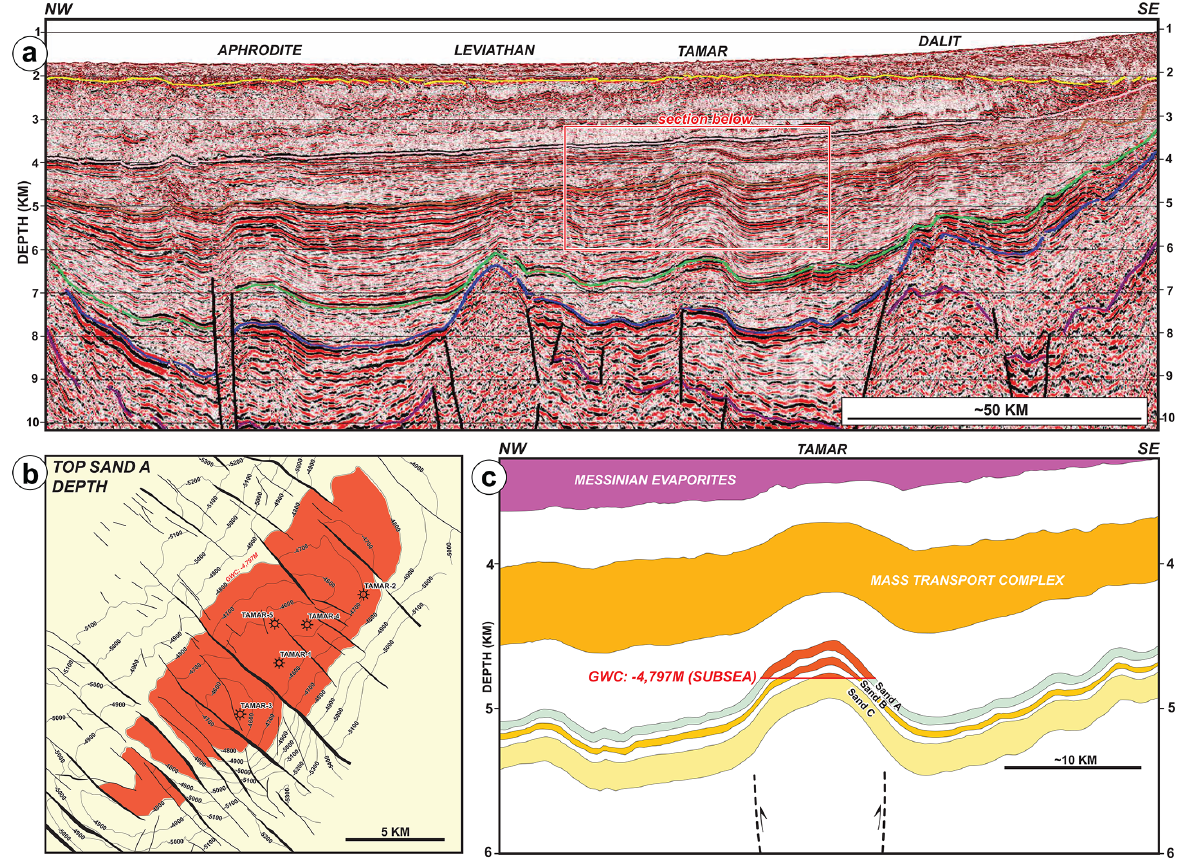
Figure 11. Highlights of the Tamar field, offshore Israel; for location, see Fig. 8. (a) Regional-scale pre-stack depth migrated seismic reflection section across the Levant Basin offshore Israel and Cyprus (Roberts and Peace, 2007). Note the large vertical exaggeration. (b) Structural depth map on the Miocene Sand A reservoir level (Needham et al., 2017). (c) Simplified cross section across the field based on Needham et al. (2017). Note the large vertical